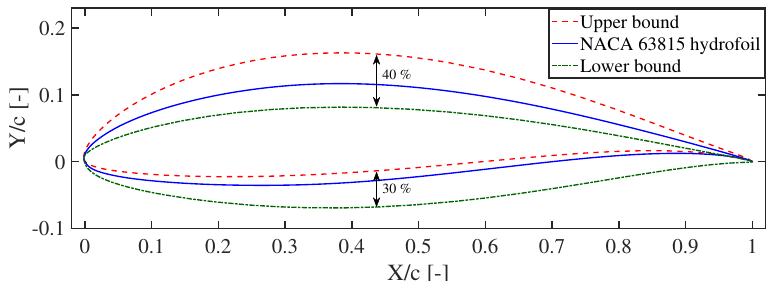
Figure 4. Optimized hydrofoil with upper and lower bounds for the